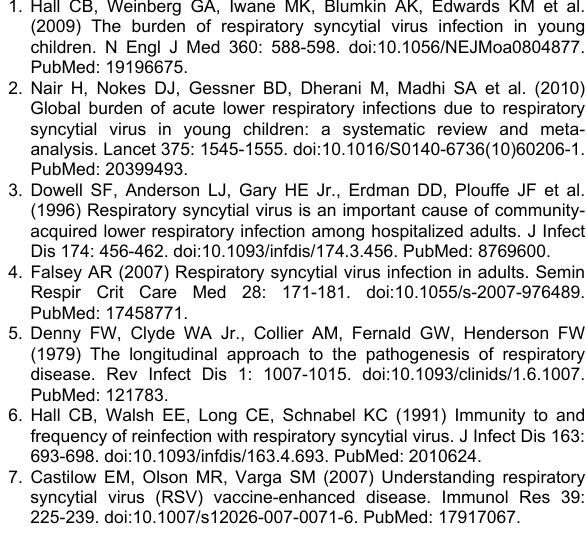
Figure S2. Enumeration of RSV M2-specific CD8 + T cells using MHC class I tetramers. BAL cell suspensions obtained from mice challenged with RSV A2 were stained with anti- mouse CD3e PE-Cy7-conjugated, anti-mouse CD8α PerCP- conjugated and APC-labeled M2-specific H-2Kd tetramer. FACS contour plots were gate on CD3/CD8 positive cells. Total numbers of M2- H-2Kd tetramer positive CD8+ T cells are shown. Error bar represents the SEM from n=5 mice per